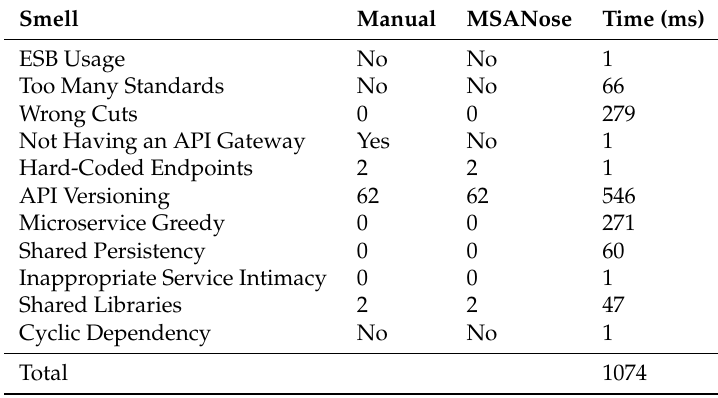
Table 3. Case study on TMS benchmark.